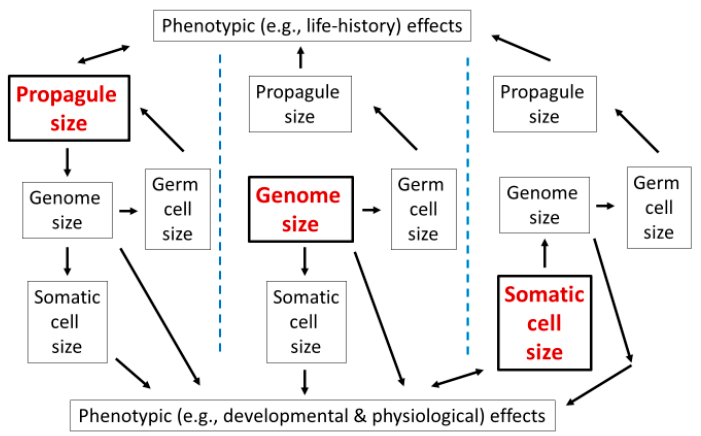
Figure 6. Hypothetical scenarios showing possible causal (functional or evolutionary) relationships among the sizes of reproductive propagules, genomes (DNA content per cell), somatic cells and germ cells. These scenarios, each of which may occur at least in some cases, attempt to explain why the sizes of the above entities are often positively correlated with one another (see Figures 1D, 2D and 4; Tables 2–5, A1 and A2). The left-hand scenario hypothesizes that natural selection for larger reproductive propagules with relatively large cells favors larger genomes for structural and functional support. These larger genomes are then passed onto somatic cells and next-generation germ cells, which are also larger because of nucleotypic effects. The larger germ cells, in turn, contribute structurally and functionally to larger next-generation propagules, thus reinforcing the adaptive evolutionary effects. The selection for larger propagules may also be associated with changes in other life-history traits. In addition, changes in the sizes of somatic cells may have secondary effects on other phenotypic traits, including rates of growth, development and metabolism. The middle scenario hypothesizes that spontaneous or environmentally induced changes in genome size affect the sizes of somatic and germ cells, and secondarily propagule size and possibly other associated phenotypic traits. The right-hand scenario hypothesizes that natural selection for larger somatic cells favors larger genomes for structural and functional support. These larger genomes, in turn, support larger germ cells and reproductive propagules with possible secondary effects on other life-history traits. The selection for larger somatic cells may be direct or the indirect result of selection on other associated phenotypic traits. All of the hypothetical scenarios include a single-celled developmental stage, and as such are informed by the Single-Cell ‘Bottleneck’ Hypothesis (SCBH) described in Table 6.